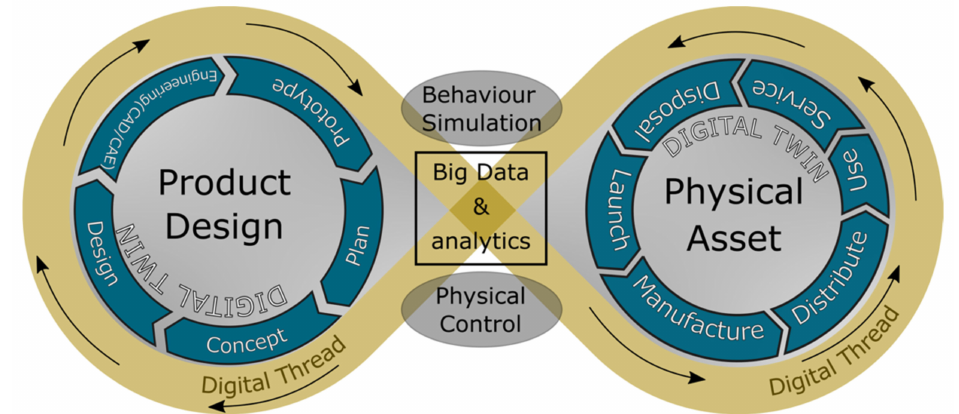
Figure 6. Digital Twin and Digital Thread framework for efficient product data